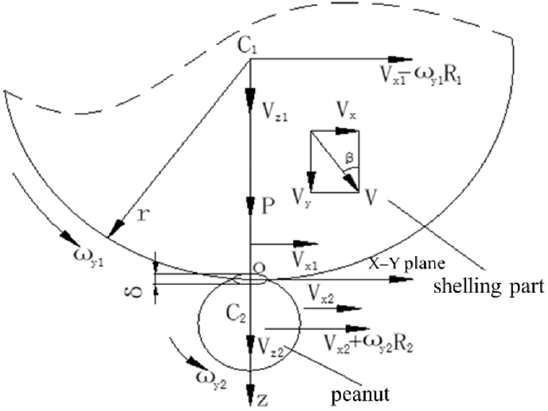
Figure 2. A kinematic scheme illustration of peanut shelling.